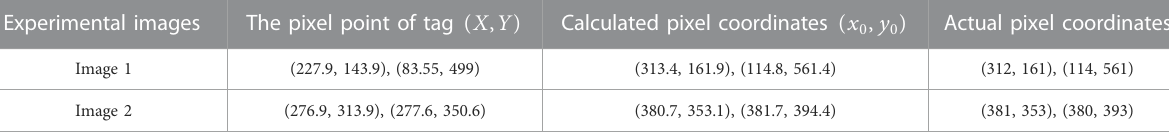
TABLE 2 Centroid coordinate point. Experimental